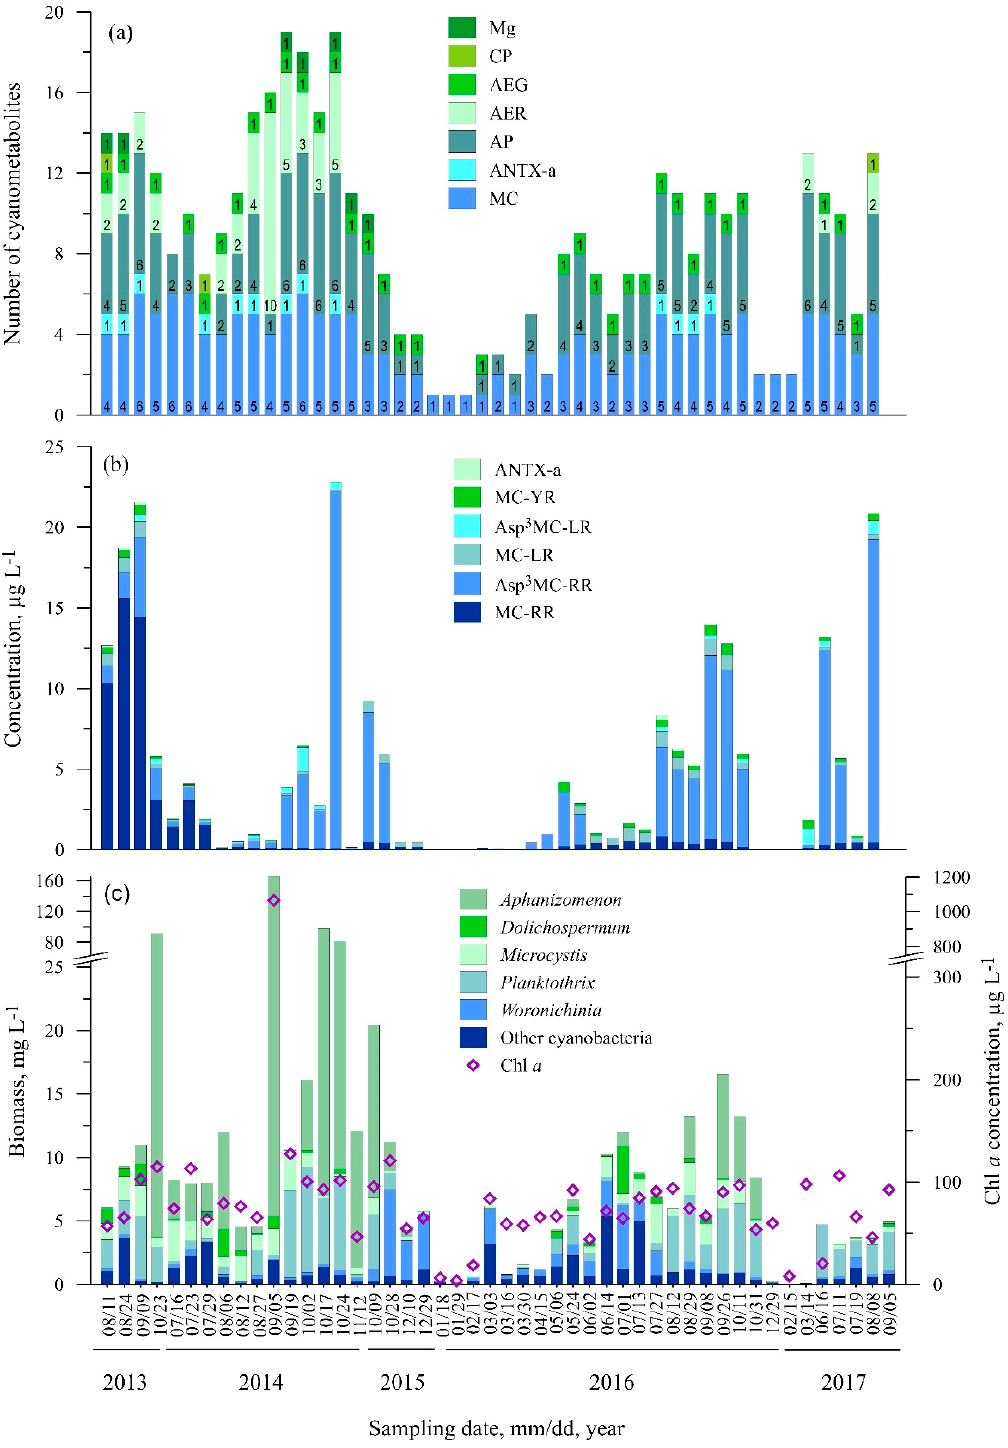
Figure 3. Seasonal changes in the number of cyanometabolites ( a ), concentration of microcystin and anatoxin variants ( b ), cyanobacteria biomass and Chl a concentration ( c ) at St. 1.